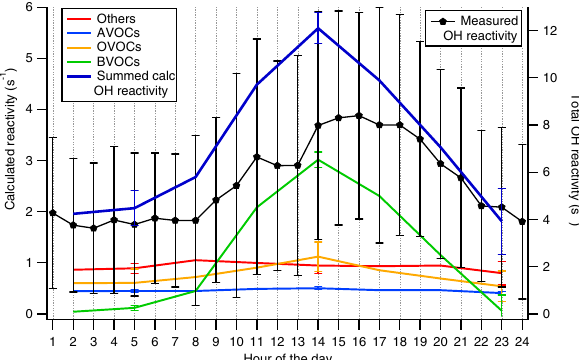
Figure 3. Diurnal patterns of measured (value with ± 1 σ , right axis) and calculated OH reactivity (left axis). Others, AVOCs, OVOCs, and BVOCs are the contribution of CO and NO x (others), anthro- pogenic volatiles, oxygenated volatiles and biogenic volatiles to the summed calculated OH reactivity.